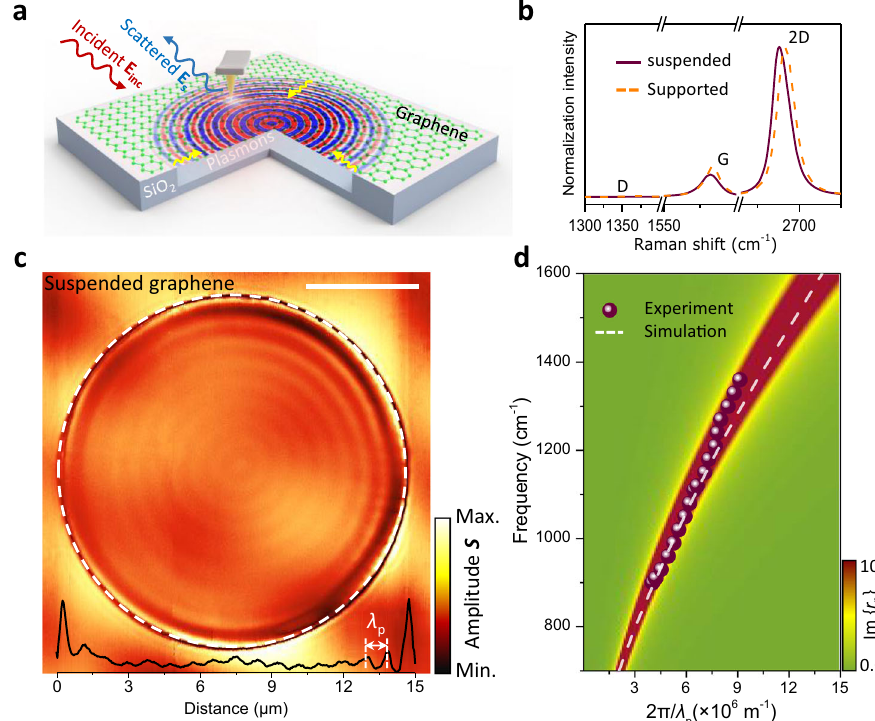
Fig. 1 Plasmonic response and intrinsic dispersion in suspended graphene structures. a Sketch of experimental arrangement for launching and detecting plasmons propagating in suspended graphene. The tip and sample are illuminated with a focused infrared light wave (with wavelength λ 0 and fi eld E inc ), which can induce dipoles around the hole edge, thus ef fi ciently exciting the graphene plasmons (yellow arrows). The tip subsequently scatters the plasmons, and a distant detector measures the scattered fi eld E S . Note that we use defocus processing to enlarge the spot size to ~30 microns and enhance the surrounding edge launching ef fi ciency further. b Raman spectra of suspended and SiO 2 -supported regions of high-quality undoped graphene. c Near- = 10.87 μ m (920 cm − 1 ) light wavelength from a two-dimensional scan across the suspended graphene area with a circular fi eld optical signal at λ 0 diameter Φ = 15 μ m and a suspension height ~450 nm. The interface between suspended and supported graphene regions is marked with a dashed white circle. The black curve at the bottom shows the near- fi eld pro fi le along with a horizontal cut through the center of the circular hole. The graphene Fermi energy is E F ~ 0.68 eV. The scale bar indicates 5 μ m. λ p represents the plasmon wavelength. d Experimentally measured (symbols, from a device with Φ = 2.5 µ m and E F ~ 0.9 eV, shown in Supplementary Fig. 4) and simulated (white dashed curve, details in Methods) dispersion of suspended GPs. The loss function Im{ r p (q, ω )}, calculated from the re fl ection coef fi cient r p in the random-phase approximation (RPA, details in Methods), is shown as a pseudo- color-plot con fi rmed by our electromagnetic simulations (Supplementary Figs. 4, 5). The plasmon dispersion relation extracted from experimental measurements (dots in Fig. 1d) is plotted and compared with RPA calculations (pseudo-color-plot background) 27 .